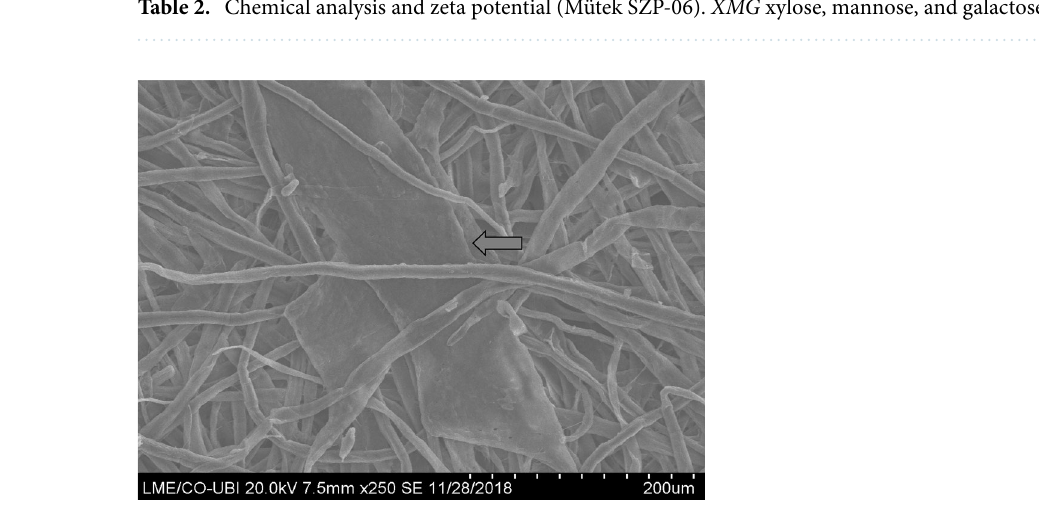
Figure 3. SEM image of a vessel rich sheet surface (the arrow indicates the